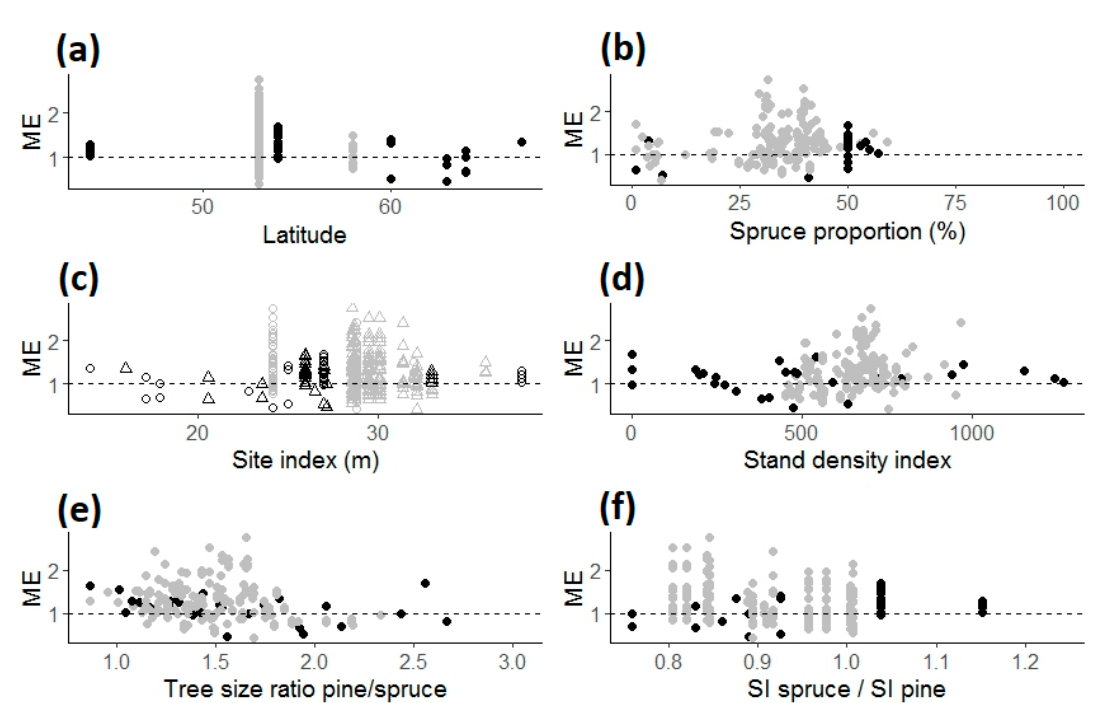
Figure 4. Mixing effect ME against different variables during different measurement periods: ( a ) latitude, ( b ) site index classes for spruce (circle) and pine (triangle), ( c ) the ratio of the mean tree size of both tree species in the mixed stand, ( d ) spruce proportion, ( e ) stand density index SDI, and ( f ) the ratio between both site indices (grey color indicates where growth of pure spruce was estimated).